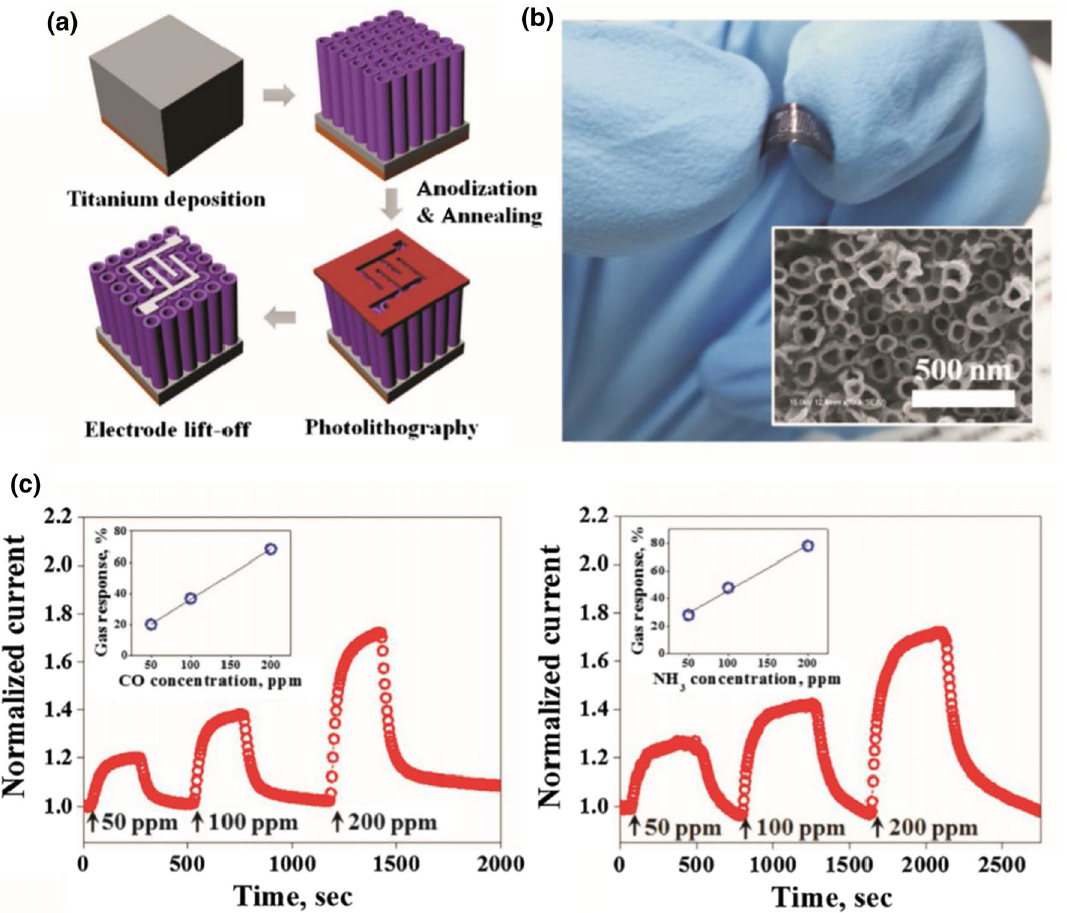
Fig. 4 a Schematic of the flexible gas sensors fabrication process, together with the real image of the flexible gas sensor and an inset show- ing the SEM image of the